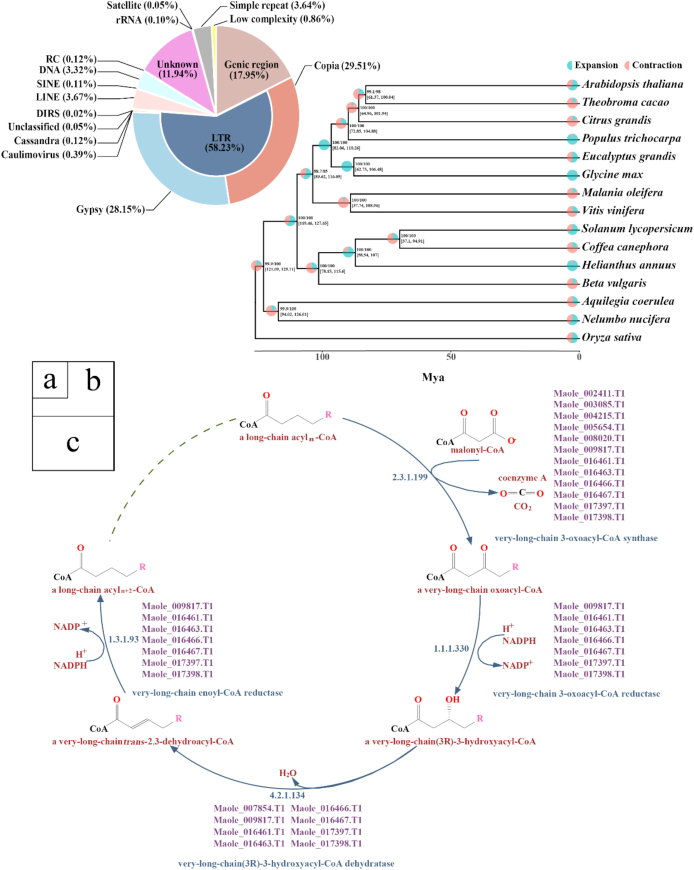
Repeat composition, phylogenomic inferences, and biosynthesis pathway for very long-chain fatty acids synthesis in M. oleifera. (a) Genome proportions of genic and various repeat sequences. (b) Phylogenetic tree, divergence time, and profiles of gene families that underwent expansion or contraction. Bootstrapping supports (SH-aLRT/UFBoot) are presented along with the 95% confidence intervals for each dating point in brackets. (c) Annotated genes involved in the biosynthesis pathway of very long-chain fatty acids (a fatty acid with minimum 22 carbon moieties) in M. oleifera.